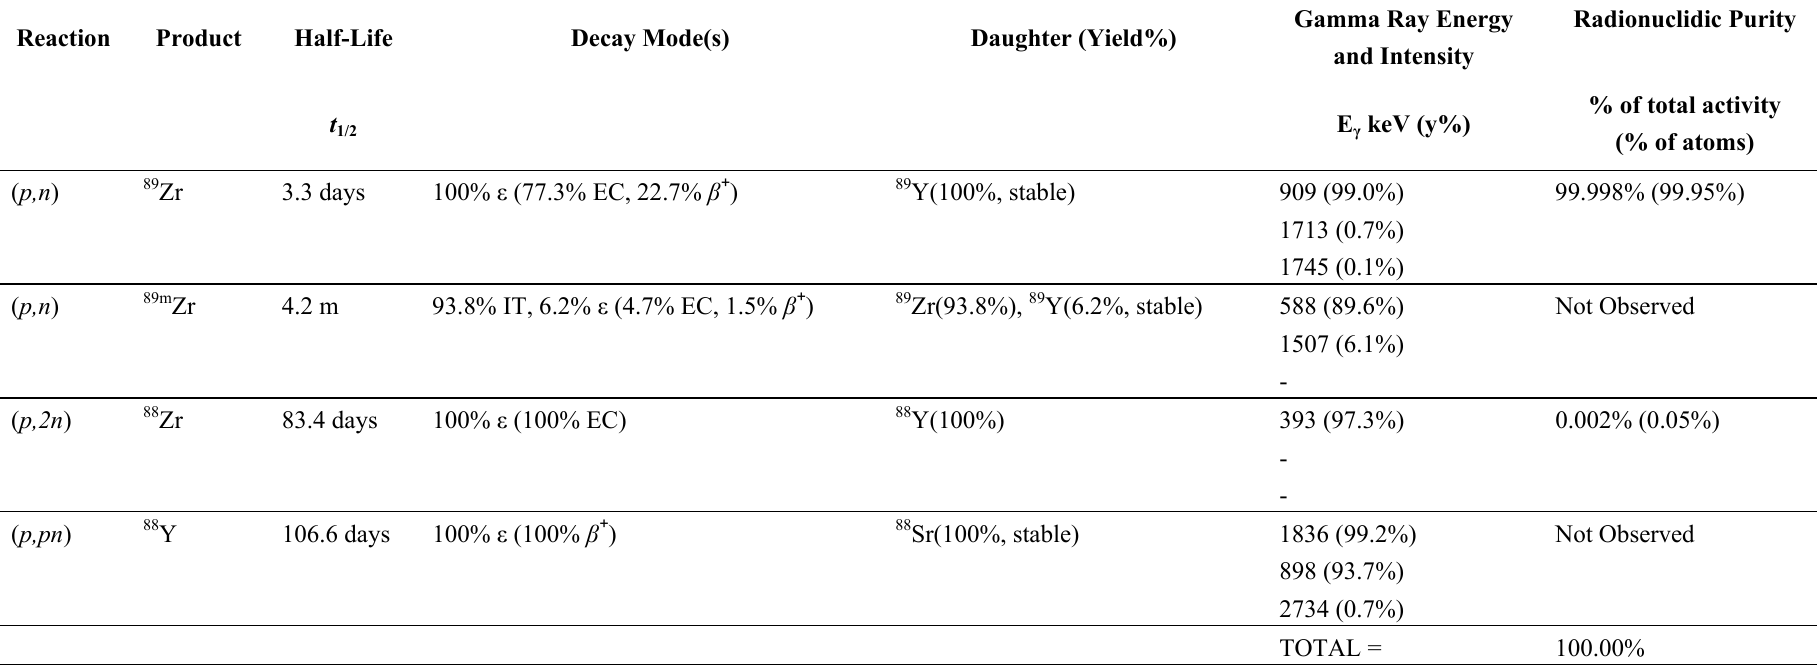
Table S2. Relevant characteristics for reactions that can be induced by 14.7 MeV protons in a nat Y foil